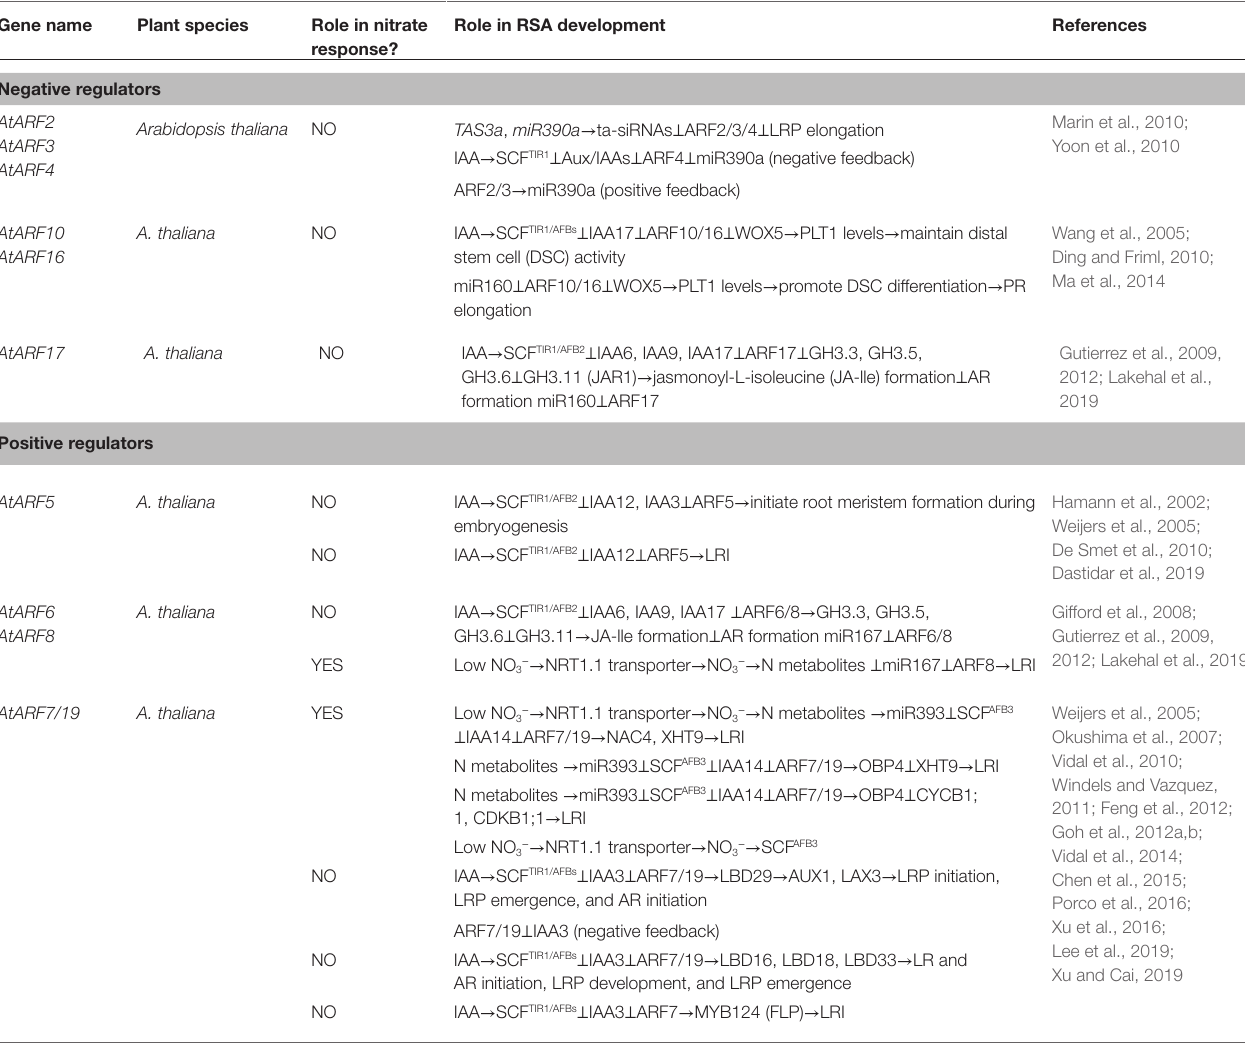
TABLE 1 | Summary of the role of ARF genes in the development of root system architecture